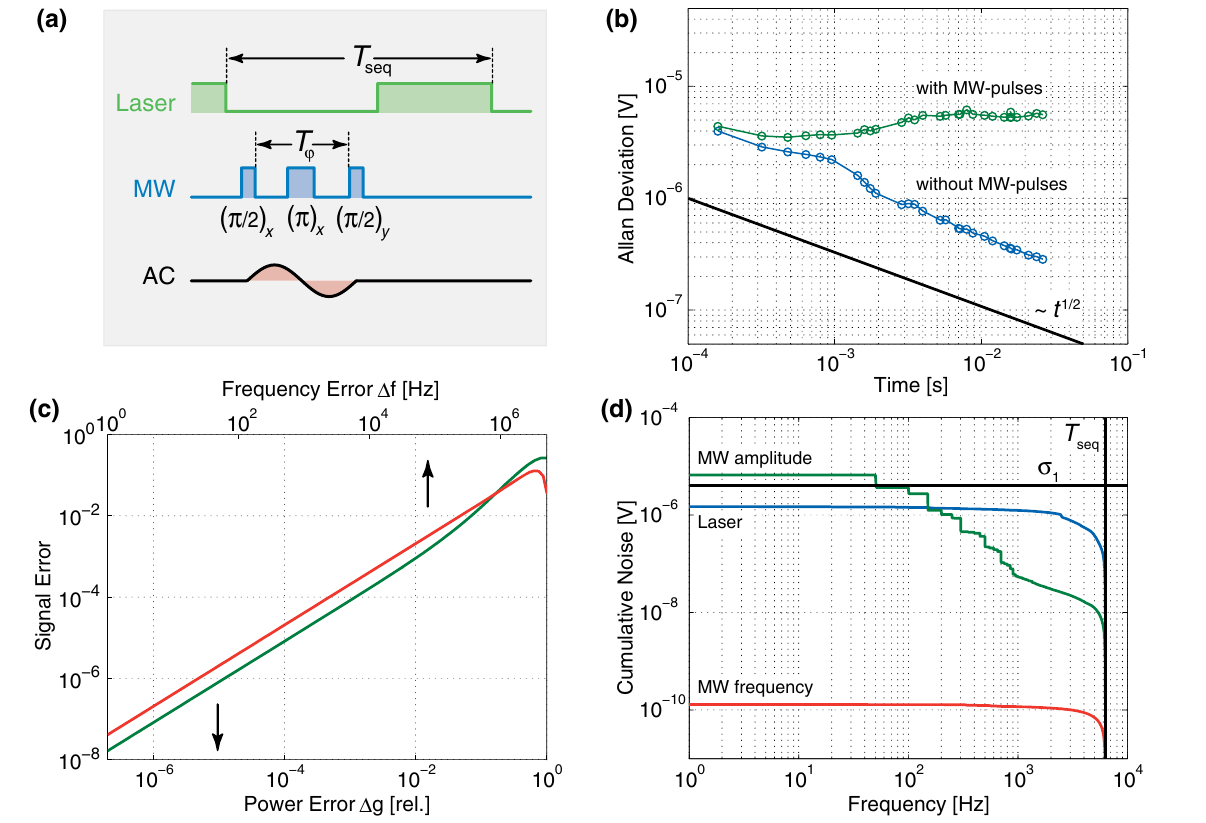
FIG. 2. Influence of non-white noise on magnetometer sensitivity. (a) ac magnetic-field measurement scheme with pulsed sensor readout. (b) Scaling of Allan deviation from the Hahn-echo sequence with (green line) and without (blue line) microwave pulses. The slope of the black line indicates the desired scaling behavior to approach a central limit. If microwave pulses are applied, scaling is worse ffiffi p t than . (c) Calculated spin-state population error ( Δ z ) after the Hahn-echo sequence over relative microwave power error Δ g (green line) and frequency error Δ f (red line). (d) Cumulative noise over sequence length T microwave power (green line), and microwave frequency (red line). The measured deviation of single readout steps σ 1 is indicated by the black horizontal line. Varying microwave power is expected to dominate the distribution of magnetic-field evaluations on longer time scales. Therefore, results of field evaluations do not share a common central limit over